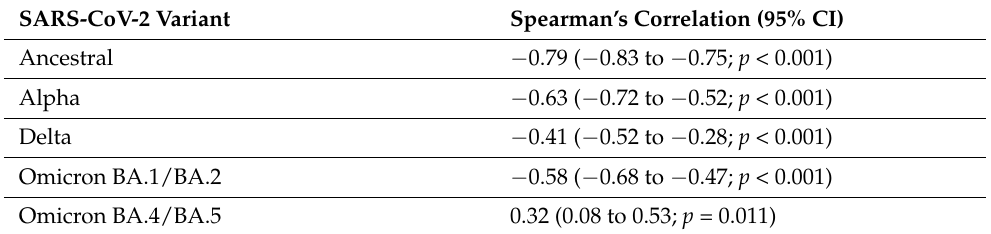
Table 2. Spearman’s correlation between the number of new daily coronavirus disease 2019 (COVID- 19) cases recorded in the province of Verona and the mean air temperature in the same area according to the period of prevalence of the different severe acute respiratory syndrome coronavirus 2 (SARS- CoV-2) variants.